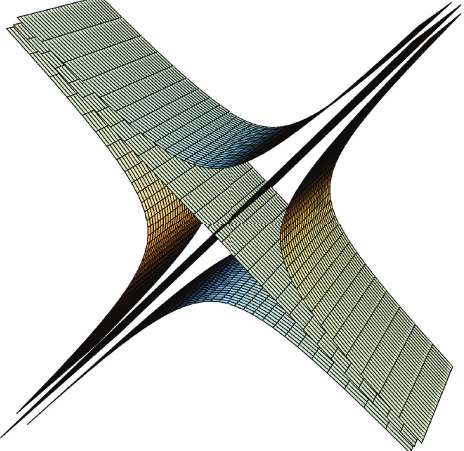
Figure 1: Lightlike planes, a spacelike and a timelike hyperbolic